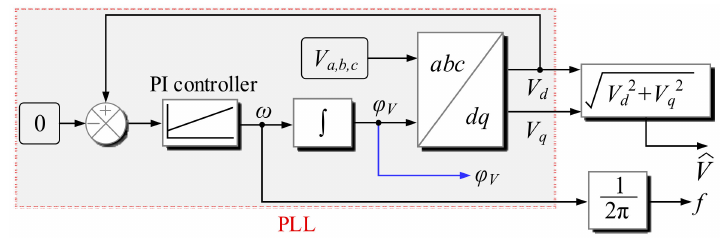
Figure 2. Block diagram of PLL for